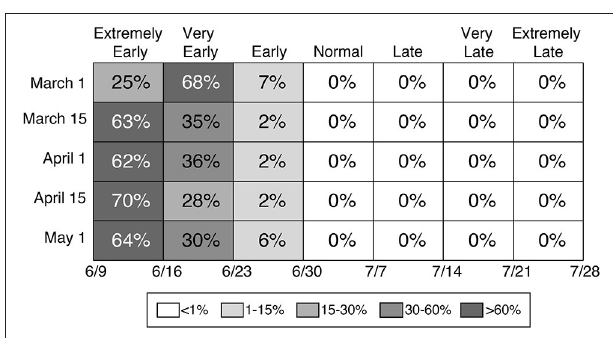
FIGURE 8 | 2012 forecast series. A forecast is run on five dates in 2012, using data available from 2002 to 2016. The boxes, representing 7-day bins, are shaded according to the proportion of mMC simulations that predict a start day in that bin (legend shown below panel), and the proportion (rounded to the nearest percent) is displayed in each box. Based on spring temperatures in 2012, a high likelihood for an extremely early start to the high landings period would have been predicted by a forecast issued as early as March 15, and this prediction remained stable through May